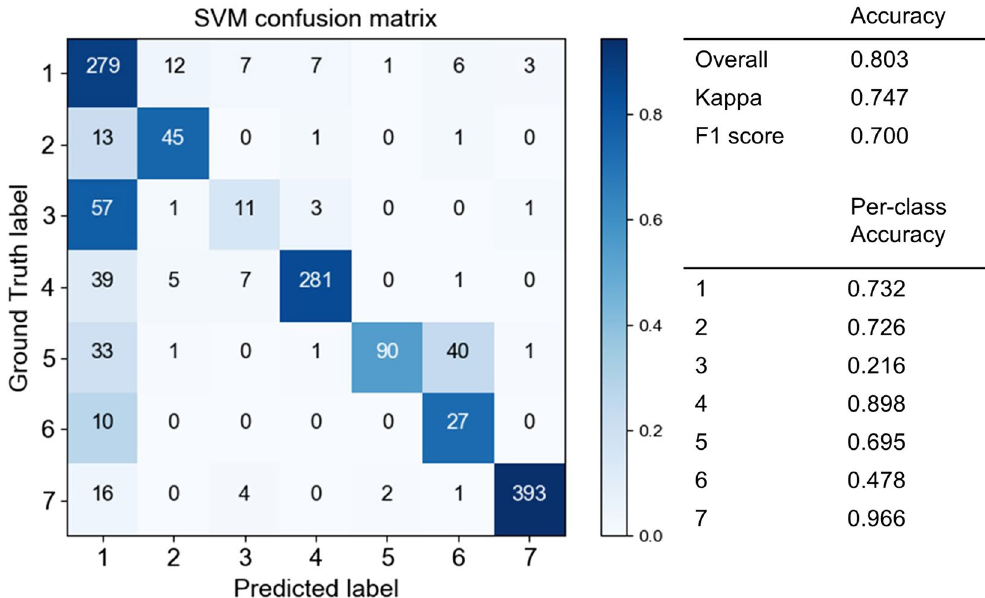
Figure 9. Confusion matrix of SVM in the green leaf season. (Class 1: deciduous broad-leaved tree; 2: deciduous coniferous tree; 3: evergreen broad-leaved tree; 4: Chamaecyparis obtuse ; 5: Pinus elliottii or Pinus taeda ; 6: Pinus strobus ; 7: